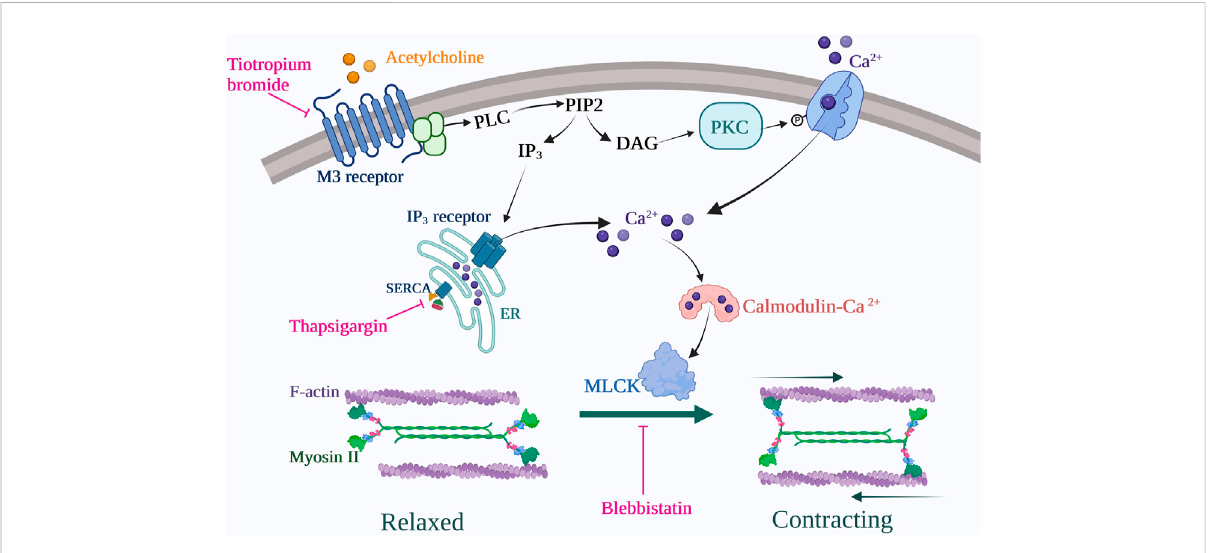
FIGURE 5 Proposed signalling pathway for COPD fi brocytes stimulated with cholinergic/muscarinic agonists. Muscarinic M3 receptor activation leads to intracellular Ca 2+ increase via emptying of endoplasmic reticulum (ER) stores as well as secondary extracellular Ca 2+ uptake (store-operator calcium entry). Cytosolic Ca 2+ rise leads to acto-myosin dimerization via myosin light chain kinase (MLCK) activation, thus leading to cell contraction. These processes are inhibited at the receptor level by tiotropium bromide (M2/M3 antagonist) use, at the endoplasmic reticulum level by thapsigargin use and at the contraction level by blebbistatin use. Created with